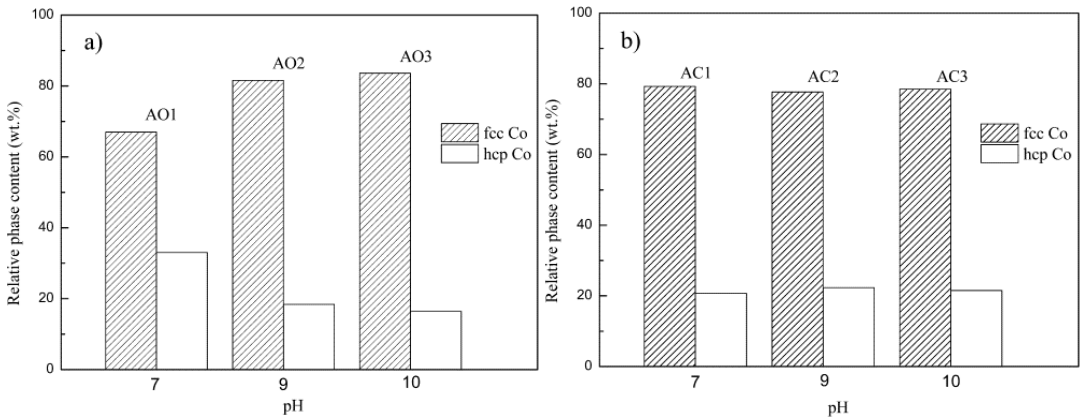
Figure 3. Relative phase content of fcc Co and hcp Co in samples of: ( a ) AO1–AO3; and ( b ) AC1–AC3.